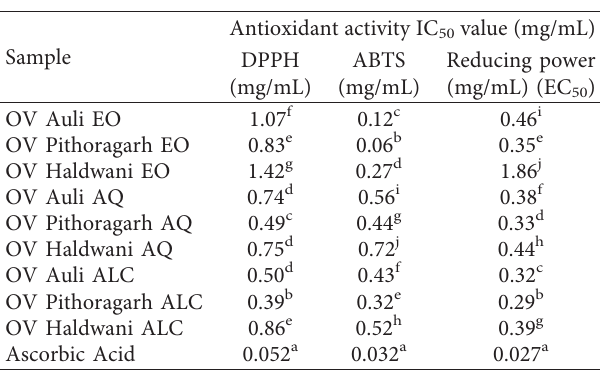
Table 8: IC 50 and EC 50 values for antioxidant assays of essential oils (EOs), aqueous extracts (AQ), and methanolic extracts (ALC) of O. vulgare along with the standard (ascorbic acid).